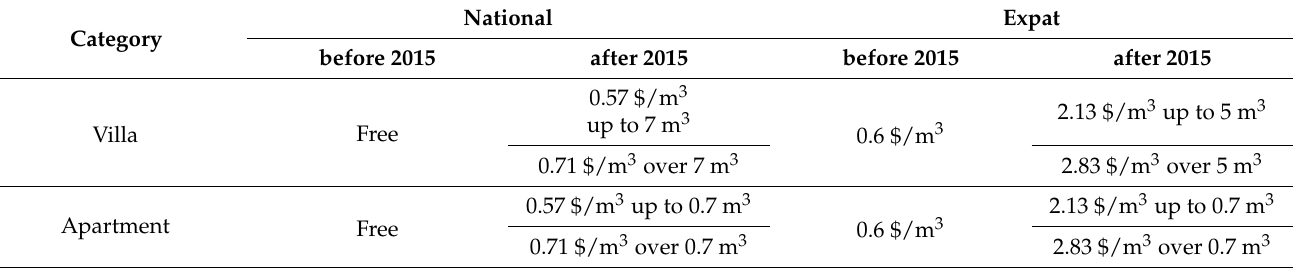
Figure 1. Map of desalination plants in the United Arab Emirates. Table 1. Water tariff per month for the residential category before and after 2015